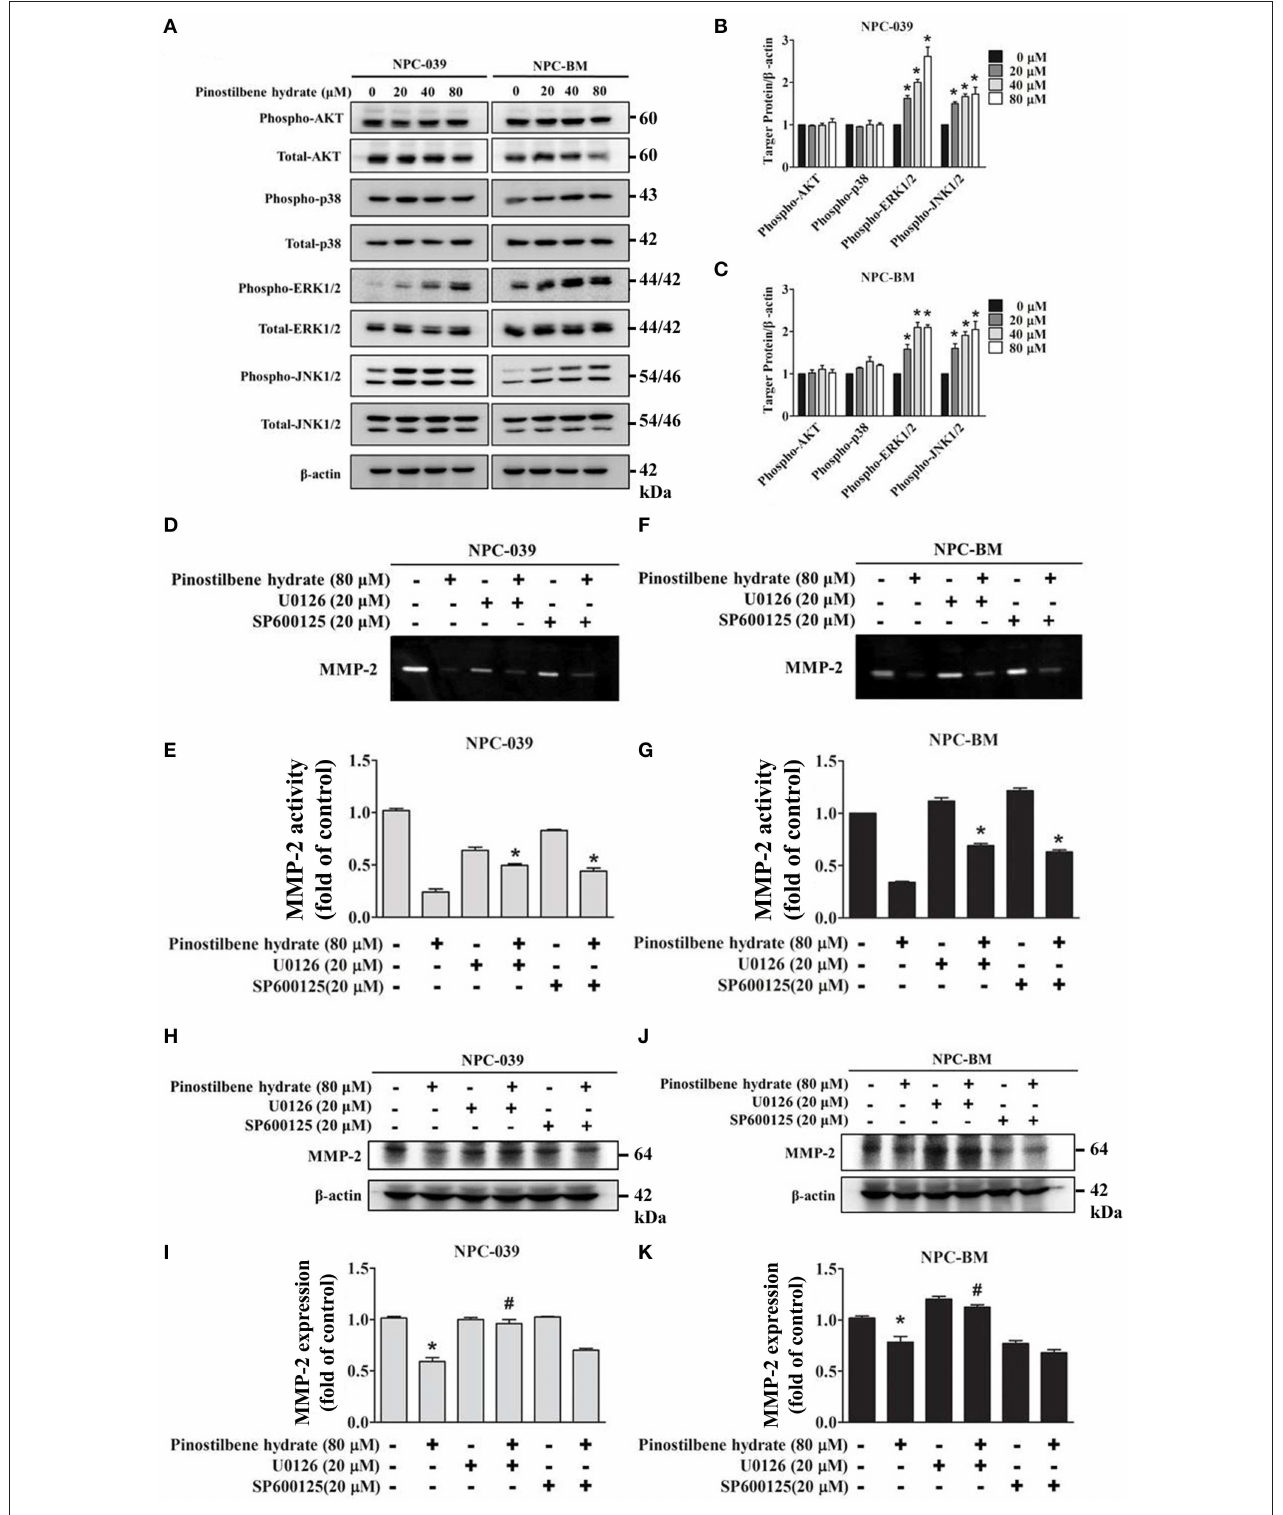
FIGURE 4 | PSH regulated the activity of MMP-2 via the MAPK signaling pathways on NPC-039 and NPC-BM cell lines. (A) Cells were treated with different concentrations of PSH (0–80 µ M) for 24h. The p-AKT, p-ERK1/2, p-JNK1/2, and p-p38 were analyzed by Western blot with their respective antibodies. The total